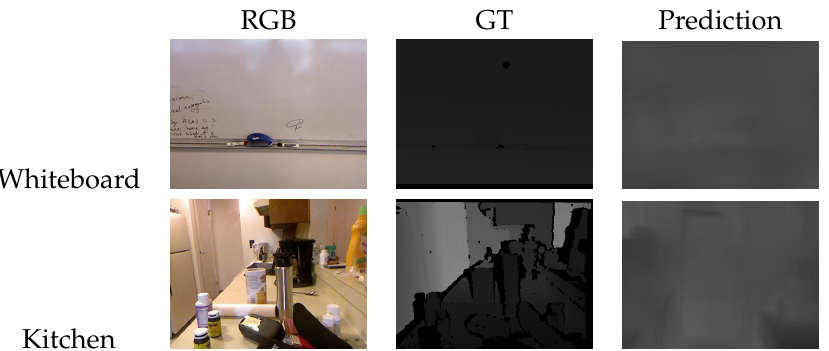
Figure 8. Example of depth map prediction with different standard deviation of depth.